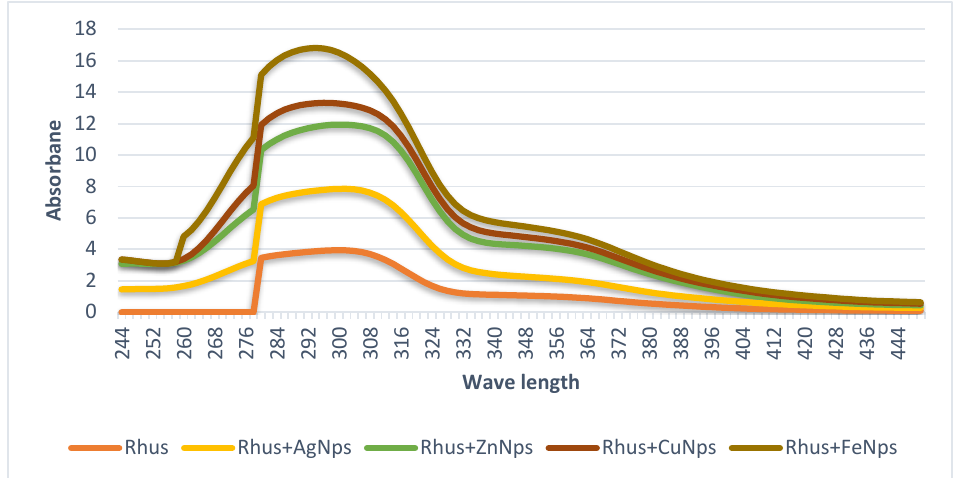
Figure 1. UV–Vis spectroscopic measurements of safflower and its prepared metal nanoparticles.